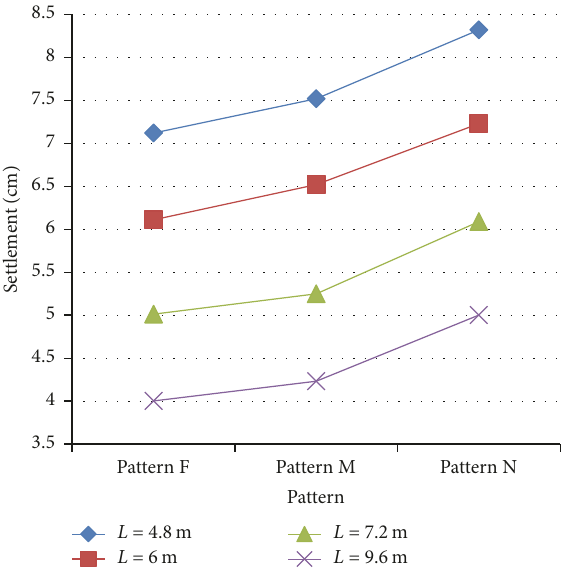
Figure 10: Static CPRF’s settlements at 90 kPa overburden.